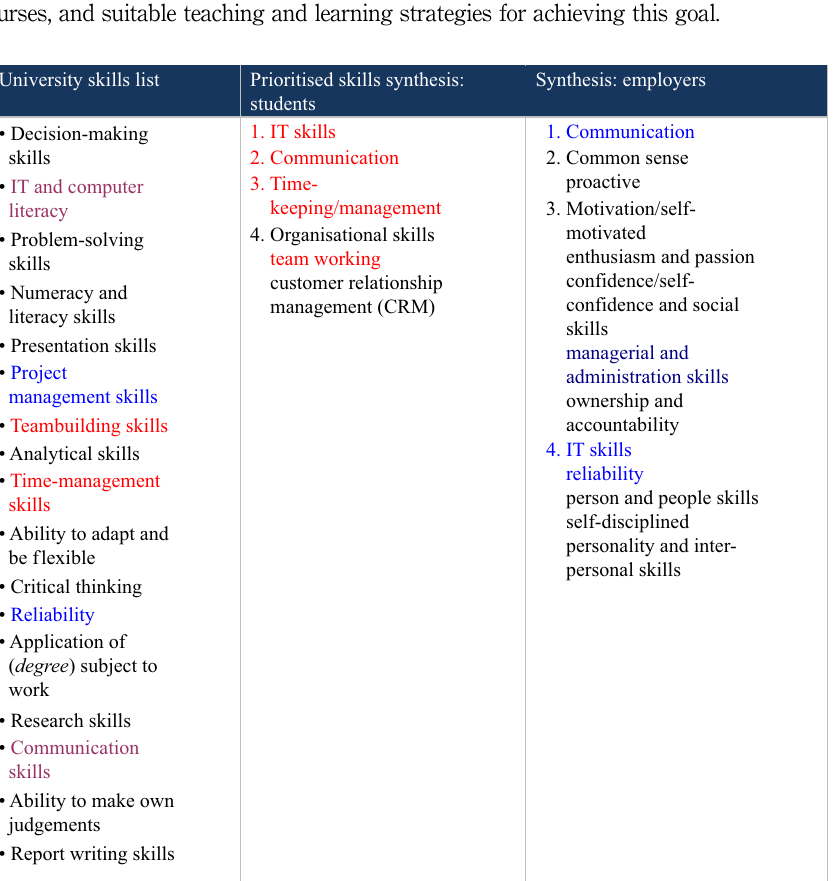
Figure 1. Employability